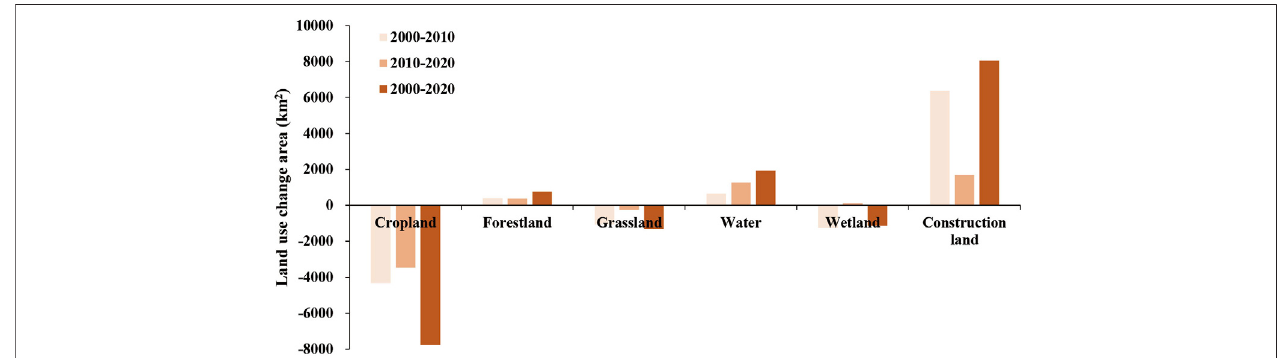
FIGURE 3 | Land use changes between 2000 and 2020 in the Beijing-Tianjin-Hebei